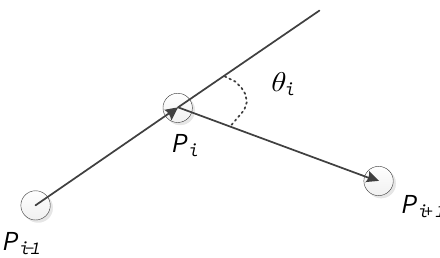
Figure 7. Schematic diagram of the rotation angle between path segments.